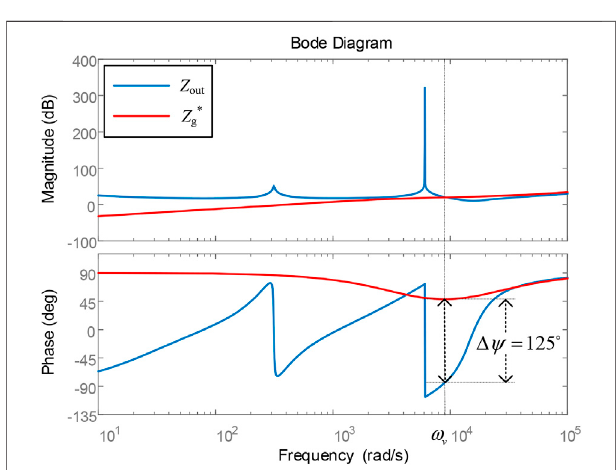
FIGURE 14 | Overall system block